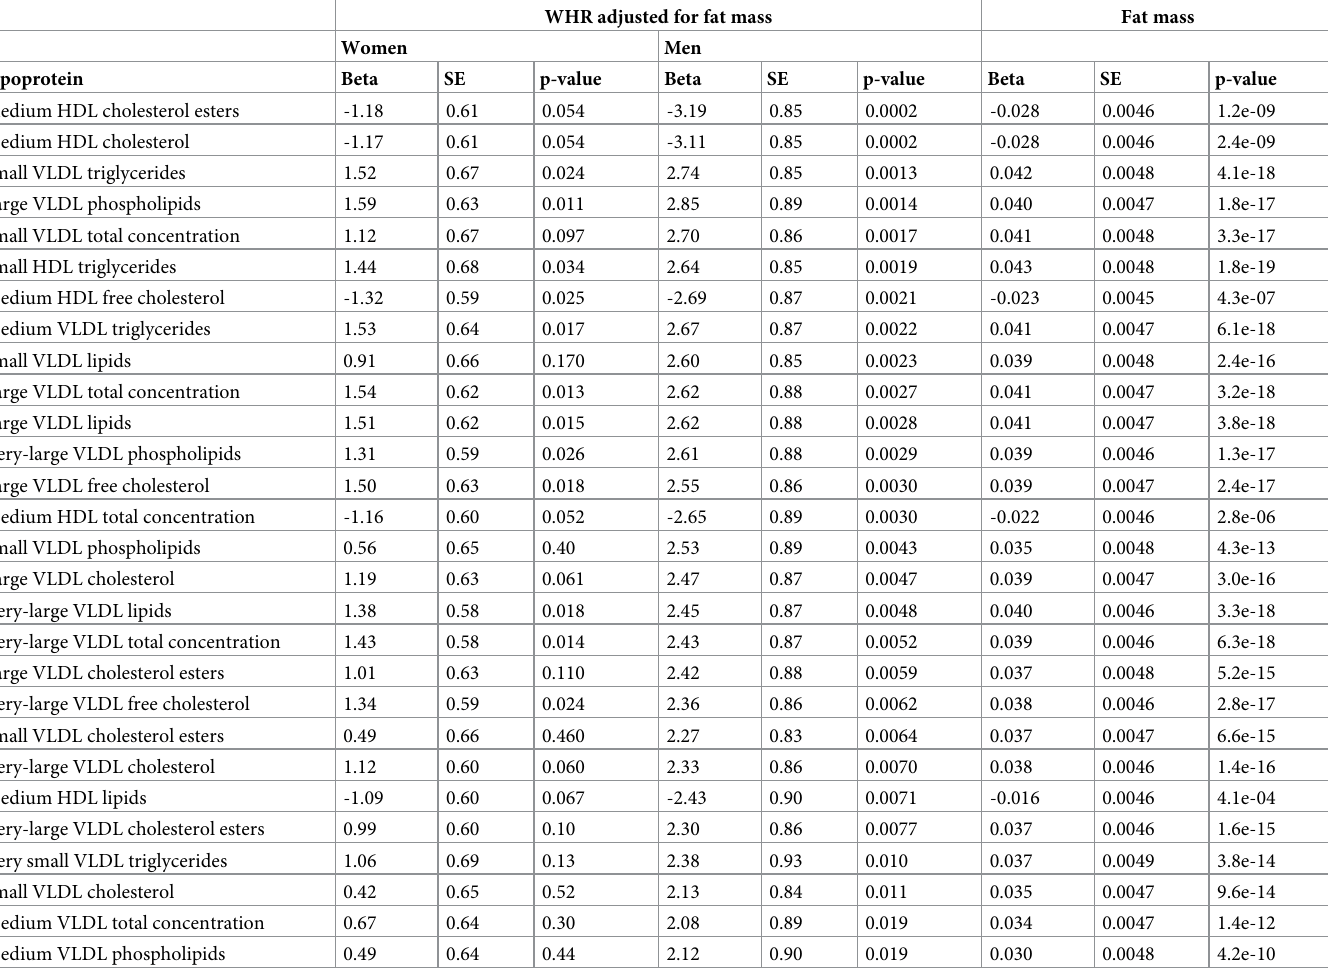
Table 4. Relationships between nuclear magnetic resonance spectrometry-based lipoprotein metabolites and waist-hip ratio (WHR) in males and females and vs fat mass in both sexes